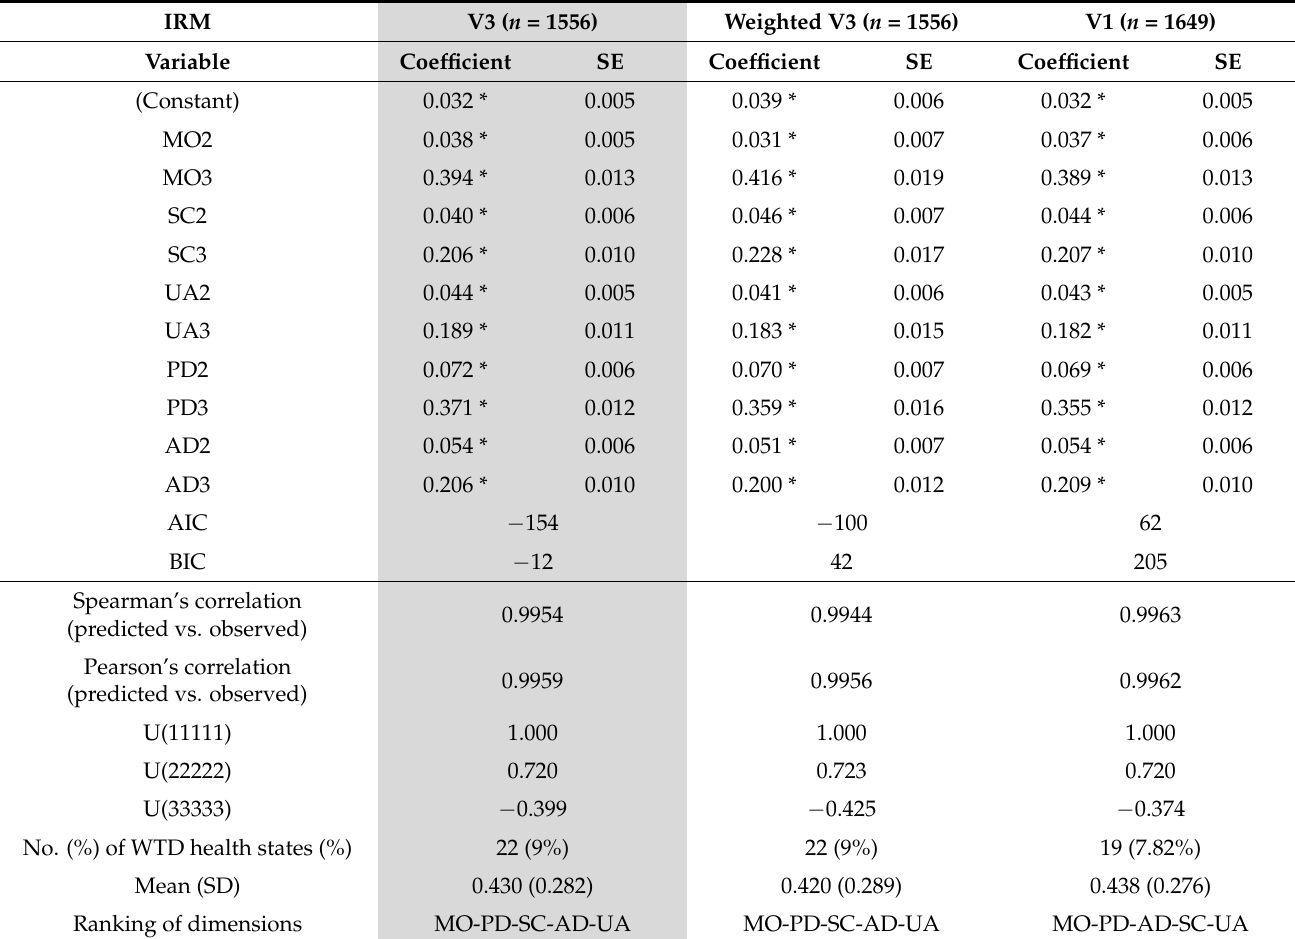
Table 5. Sensitivity analysis